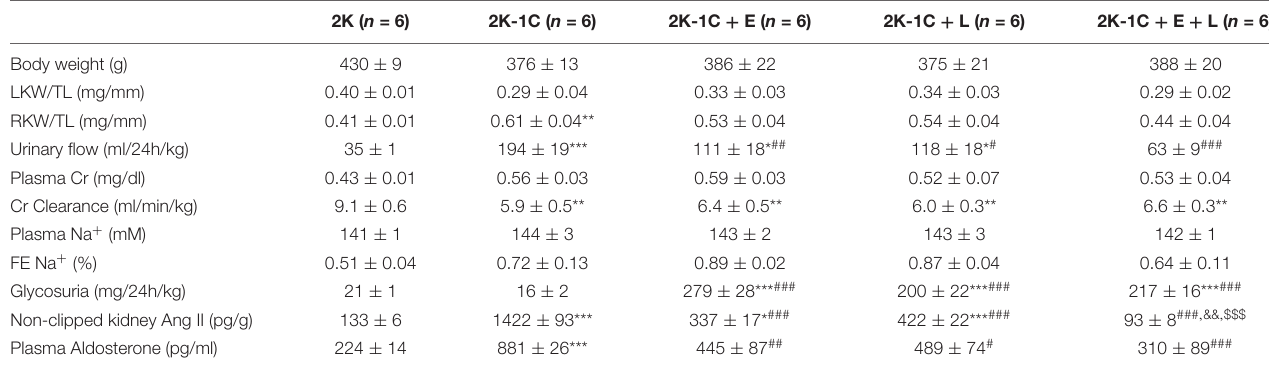
TABLE 1 | Biometrical and renal function parameters, non-clipped kidney Ang II content and plasma aldosterone concentration in two-kidney one-clip (2K-1C) renovascular-hypertensive rats and controls